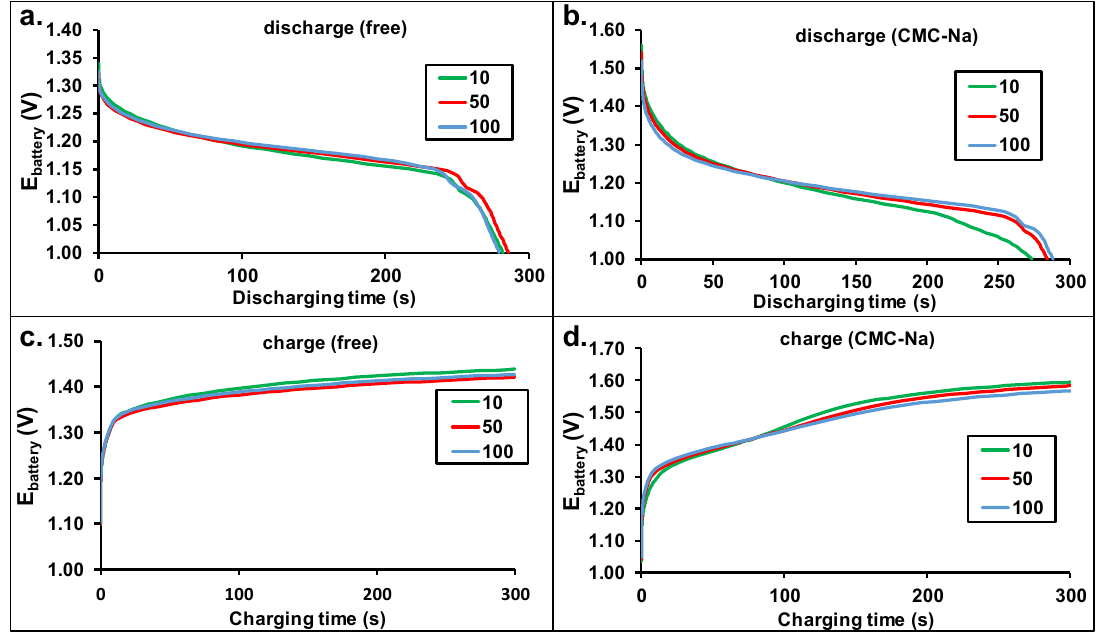
Figure 6. The cell potential change during the charging and discharging steps (10th, 50th, 100th) of the Zn-air batteries equipped with brass anode without ( a , c ) or with additive ( b , d ) in the electro- lytes.